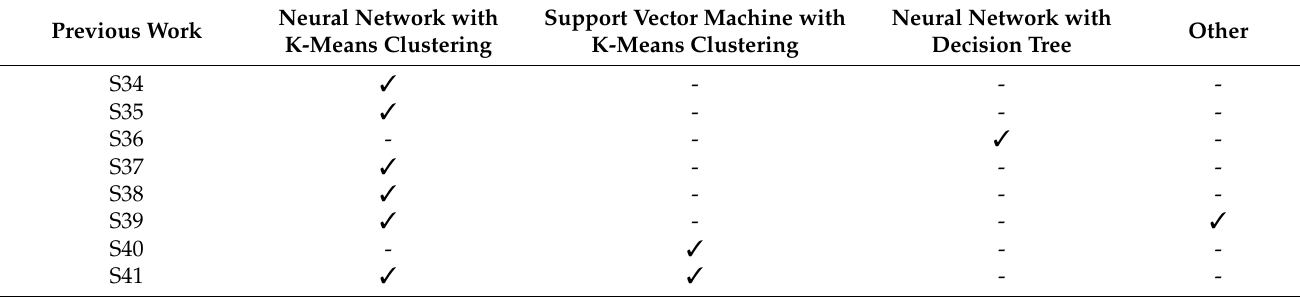
Table A4. Major combination prediction and classification techniques of energy consumption of